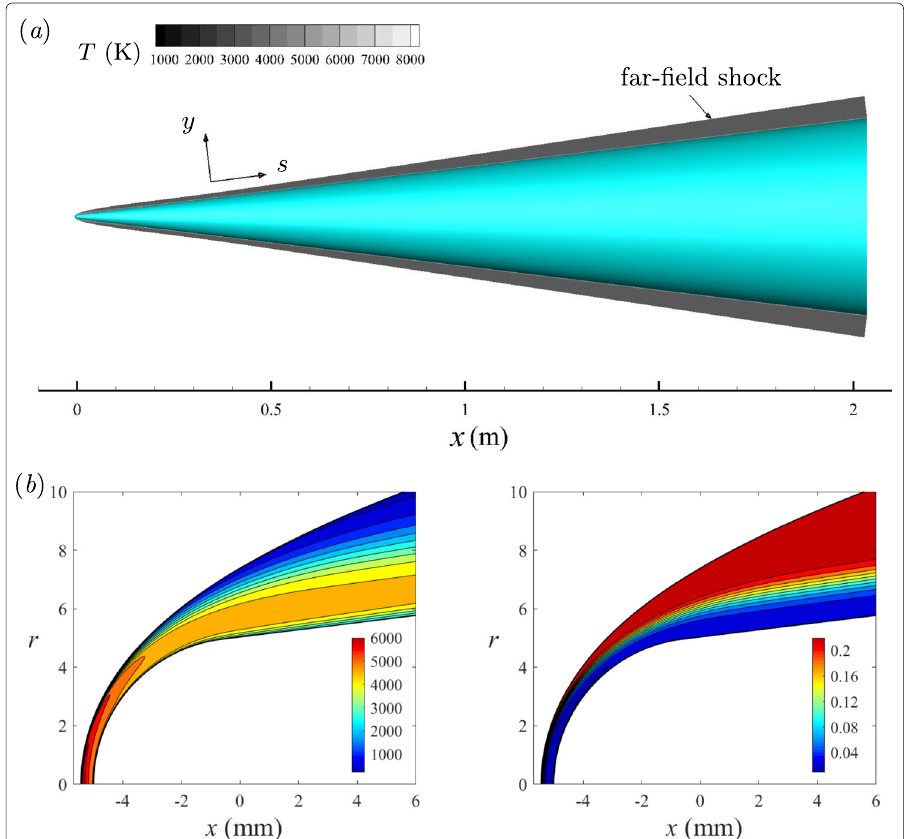
Fig. 1 Laminar flow contours of ( a ) the whole computational domain and ( b ) the nose region (left: vibrational temperature T v ( K ), right: mass fraction of O 2